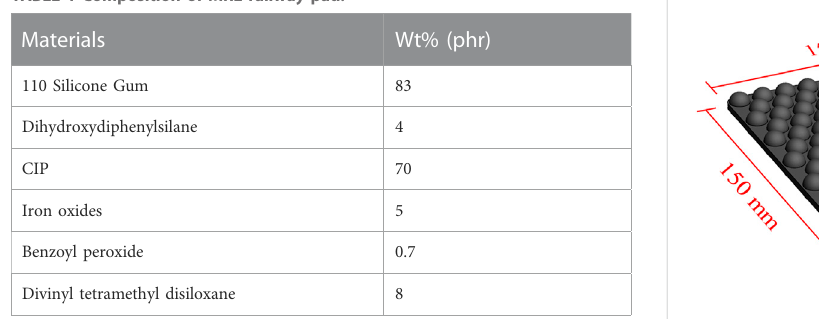
FIGURE 1 The design and structure of MRE railway